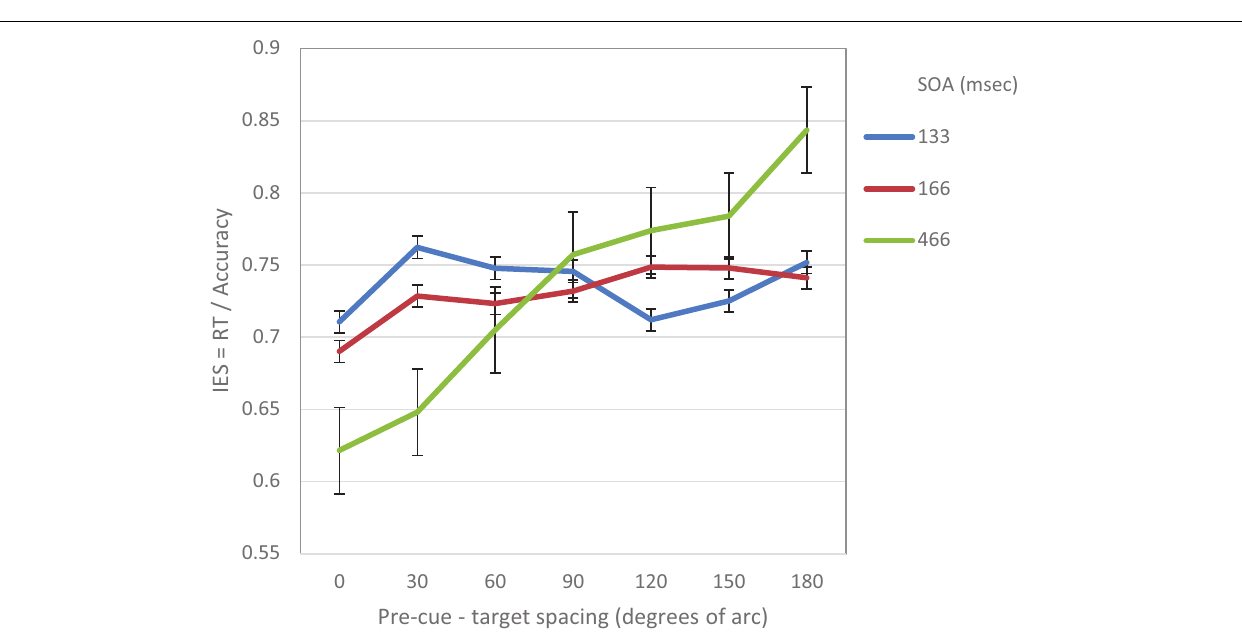
than 2 s or shorter from 0.2 s were excluded from the analyses (0.6%). On this data, repeated measures two-way ANOVA was performed, with SOA and pre-cue – target distance as